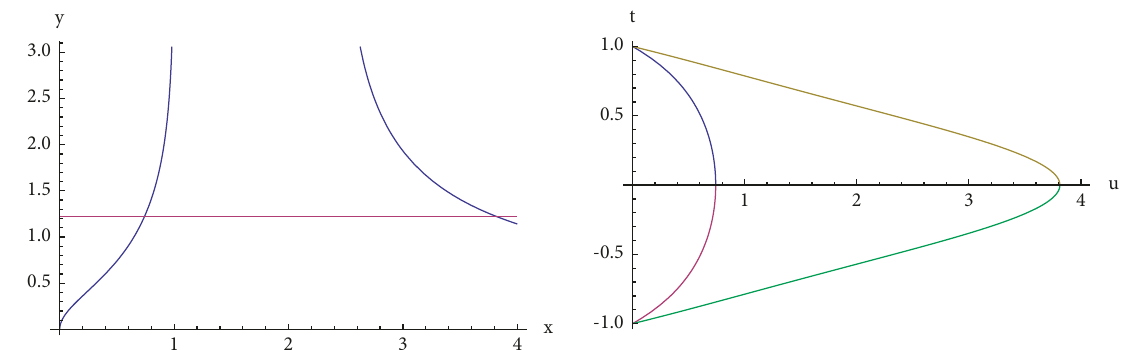
Figure 5: Graphs of y � H ( x ) and 2 positive solutions for DBVP (1) and λ �